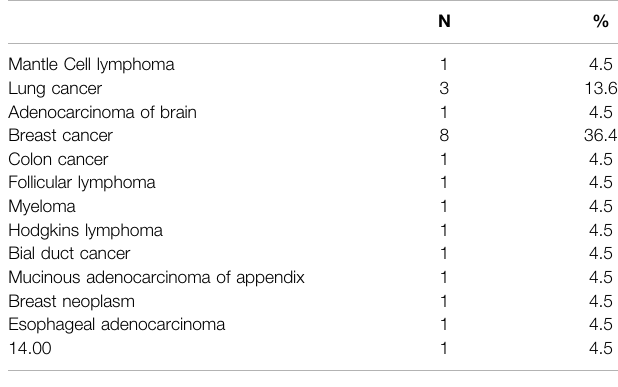
TABLE 2 | Sample demographic by diagnosis.